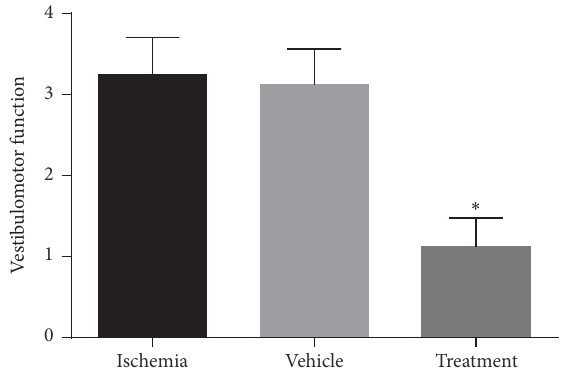
Figure 8: Effects of bone marrow mesenchymal stem cells (BMSCs) on vestibulomotor function in rats after cerebral ischemia. Signifi- cant difference with treatment group ( 𝑃 < 0.05 ) (shown with ∗